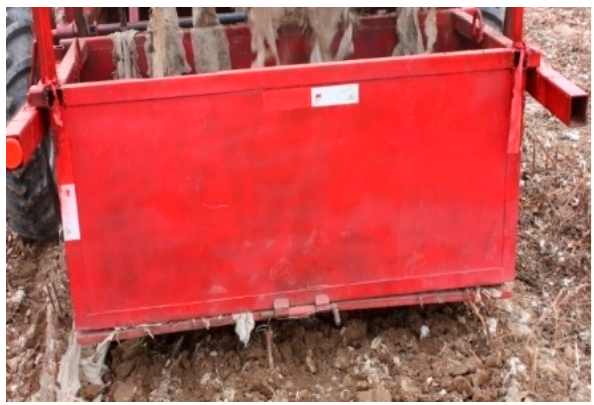
Figure 16. Field